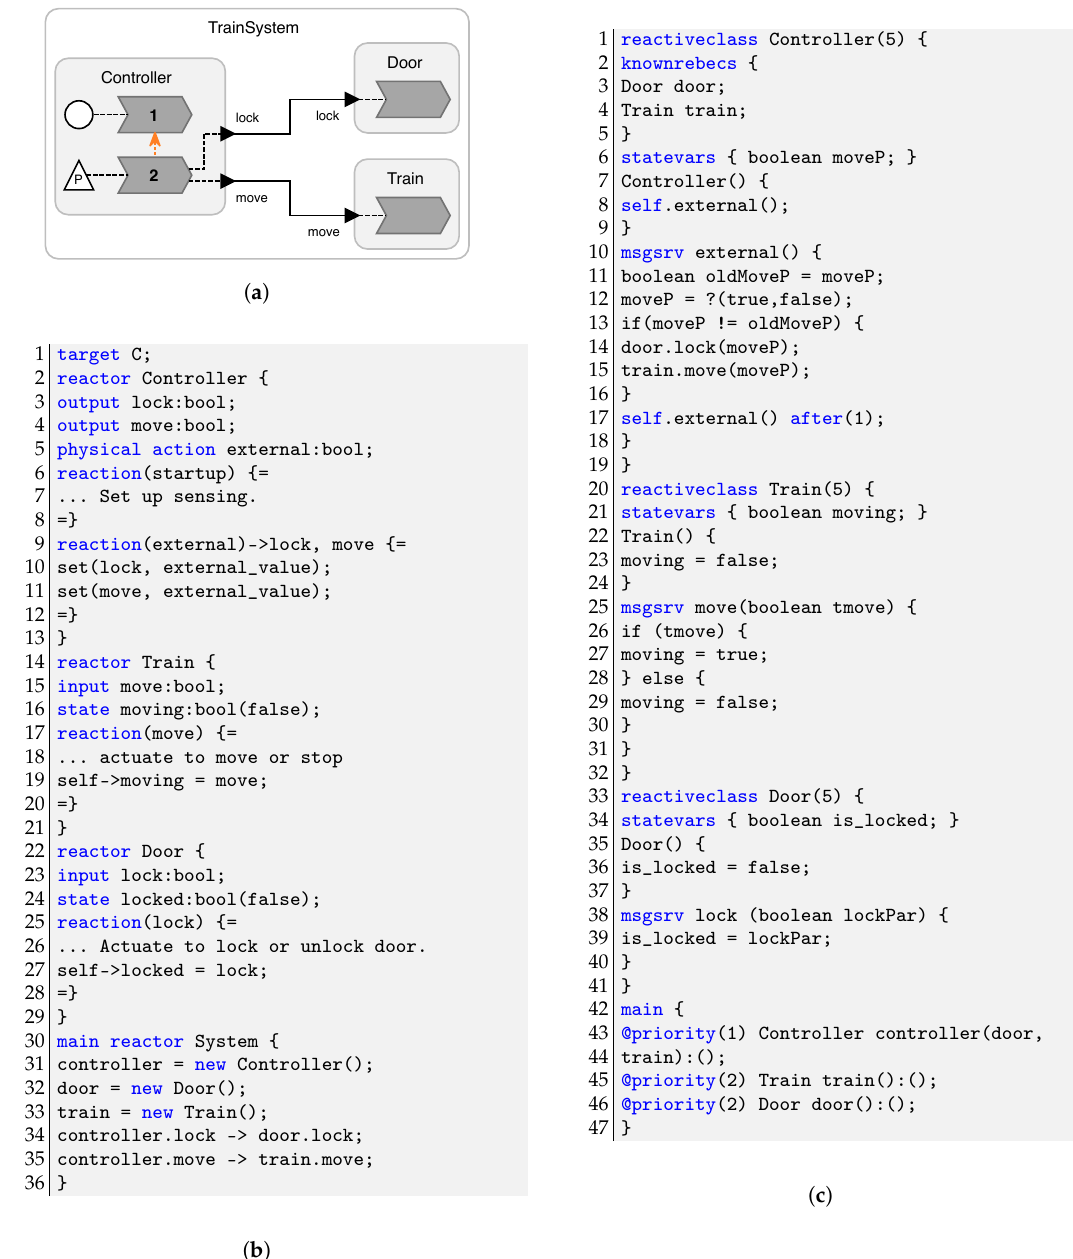
Figure 2. The structure, Lingua Franca program, and Timed Rebeca model for the simple door controller example. ( a ) Structure of the simple door controller example. This image is rendered automatically by the Lingua Franca IDE using the KIELER Lightweight Diagrams framework [28]. ( b ) Lingua Franca code for the simple door controller example in Figure 2a with a potential defect. ( c ) Timed Rebeca model (extended with priorities) for the simple door controller example in Figure